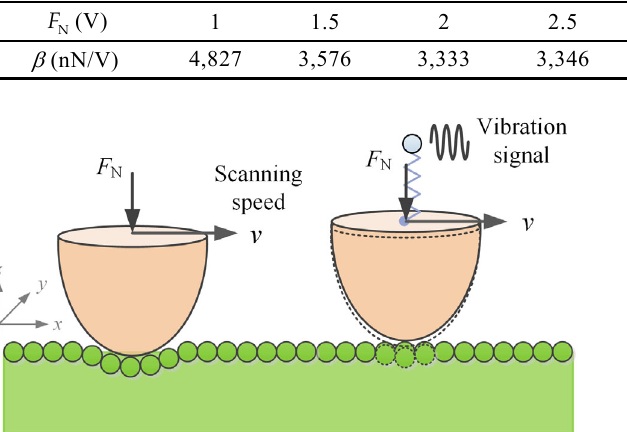
Table 1 Calibration values for lateral sensitivity coefficient corresponding to various